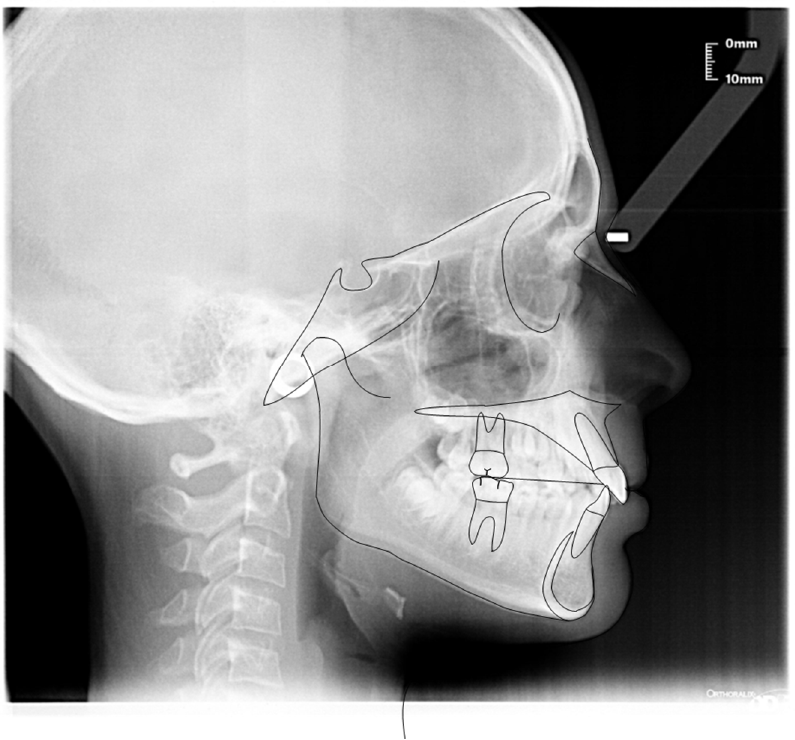
Figure 6. Cephalometric tracing (DeltaDent software) before treatment (10-year-old) reveals a skeletal class I. Table 1. Cephalometric analysis before treatment.